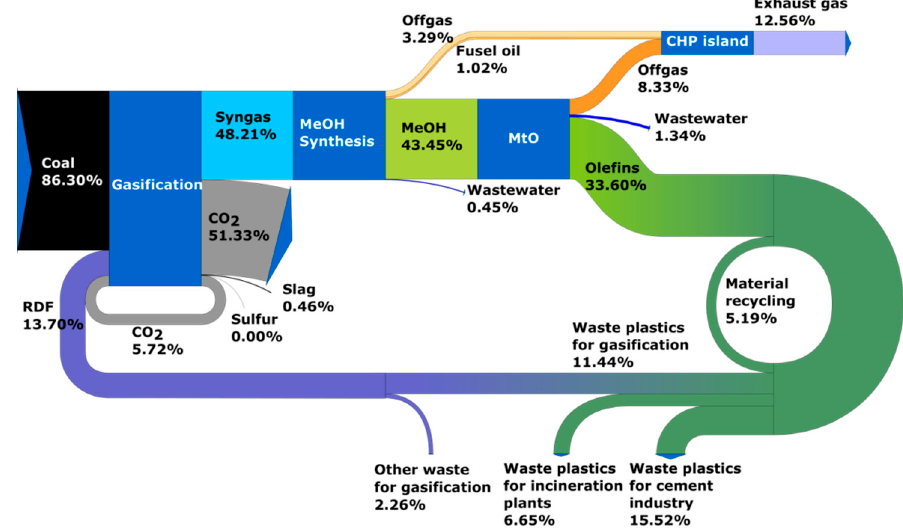
Figure 9. Carbon element distribution in olefins from hard coal and RDF production system (2030).